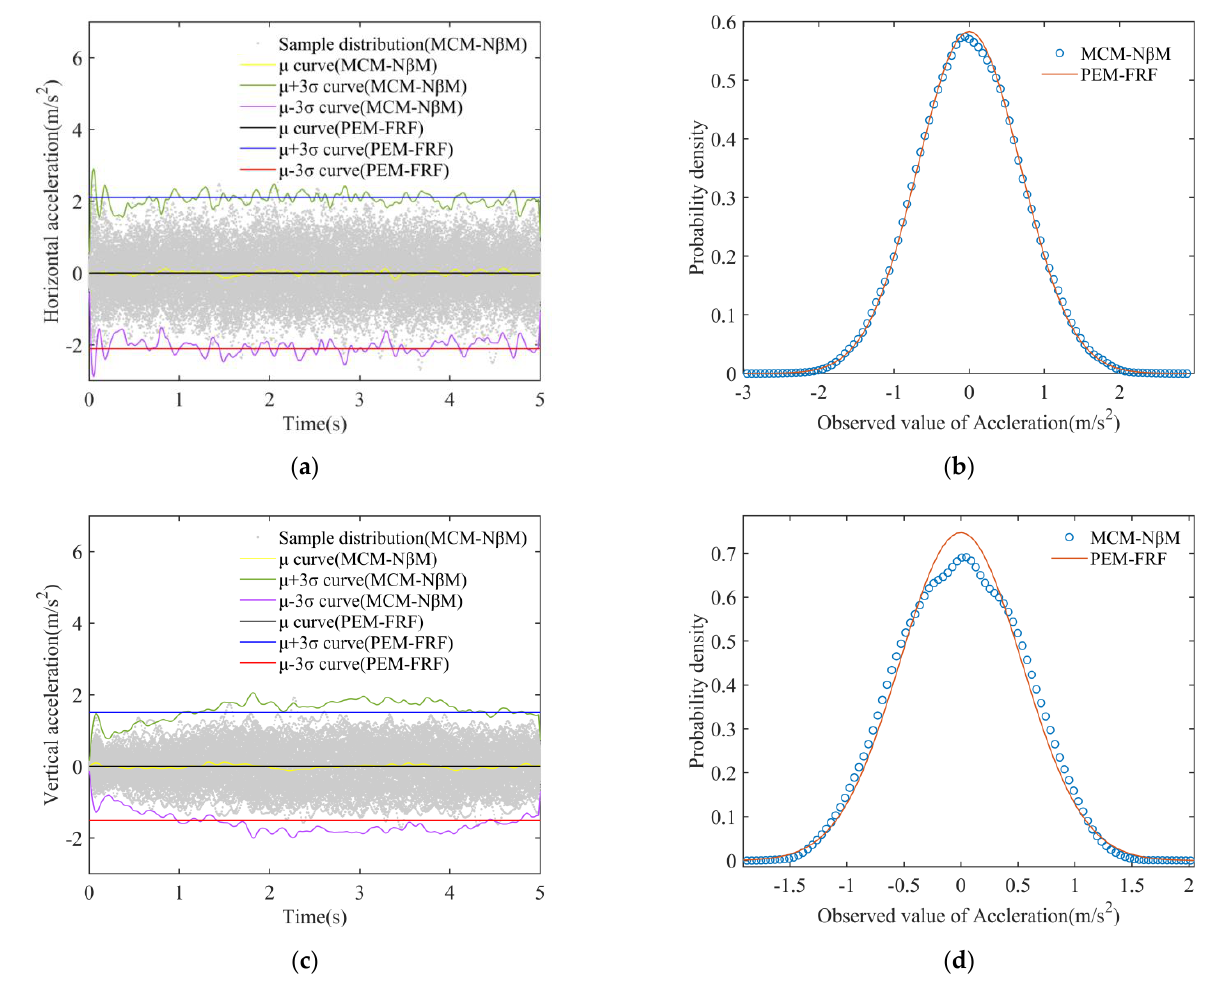
Figure 4. Car-Body center vertical and horizontal vibratory acceleration responses: ( a ) history samples distribution for the horizontal; ( b ) possibility density curve for the horizontal; ( c ) history samples distribution for the vertical; ( d ) possibility density curve for the horizontal.